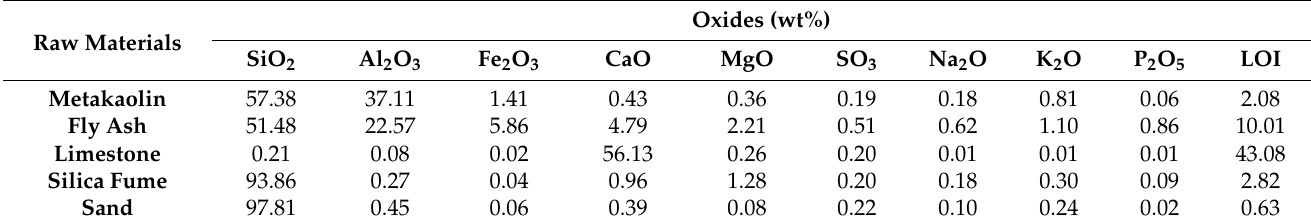
The nature of the crystalline phase present in the powders was investigated by using X-ray diffraction measurements. XRD patterns were obtained at room temperature using a Bruker D8 (Bruker, Madison, WI, USA), employing CuK α radiation as the X-ray source (operating voltage was 40kV and current was 40 mA). XRD data were collected in the 10–70° 2 θ range, with a 0.059° step-scan and at 5 s per step. The XRD patterns of metakaolin (MK), fly ash (FA), limestone (LM), and silica fume (SF) are given in Figure 1. All XRD peaks of limestone can be attributed to calcite (JCPDS: 88-1807). XRD reveals the amorphous nature of the silica fume. The XRD pattern of metakaolin shows a mixture of quartz (JCPDS: 46-1045) and residual kaolinite (JCPDS: 29-1488) in addition to the main amorphous phase. The fly ash powder is largely amorphous, with a small amount of mullite (JCPDS:15-0776) and quartz phases. These results are in perfect agreement with the XRF analysis.